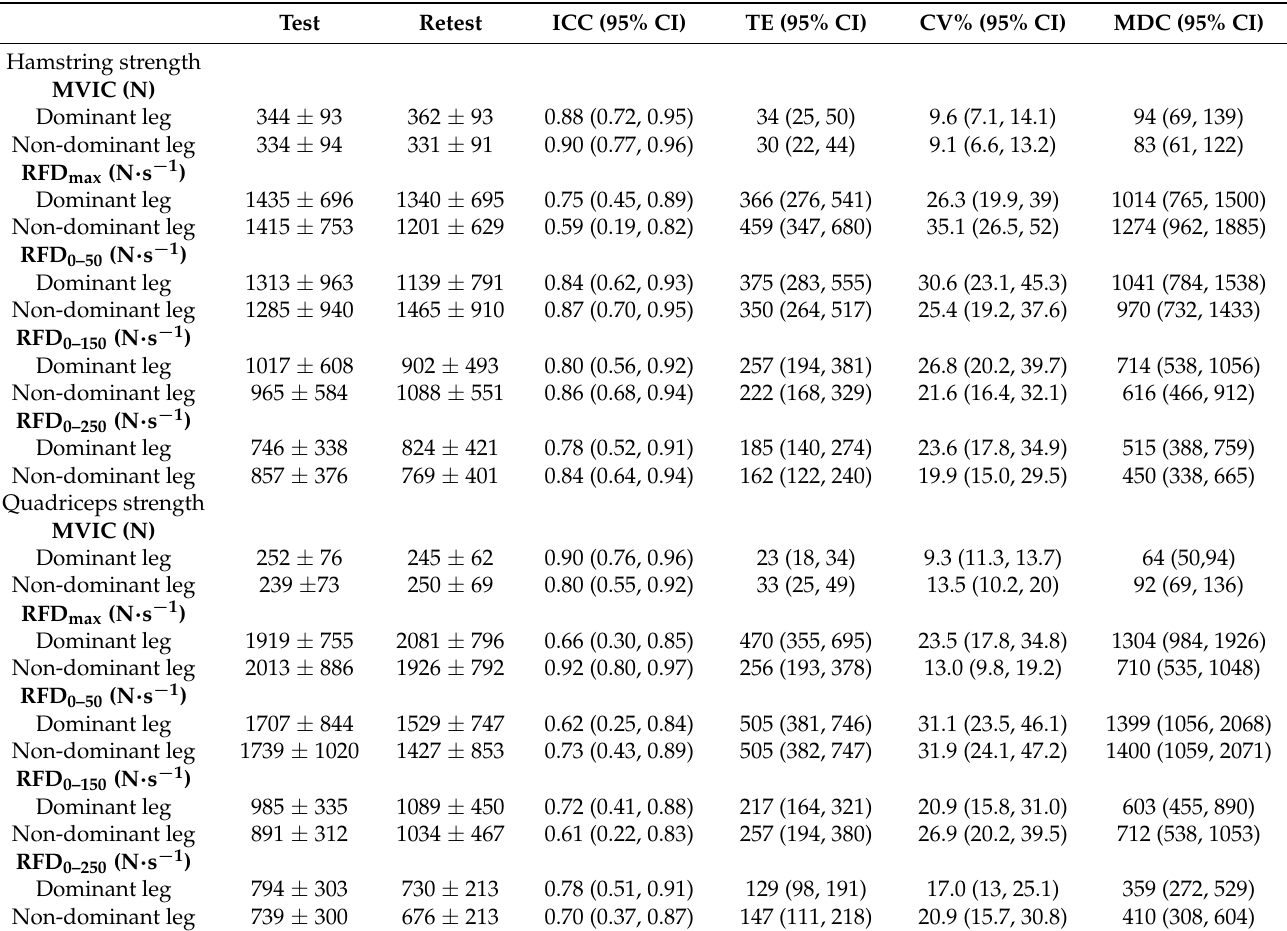
Table 1. Reliability of isometric hamstring and quadriceps strength measured through a field-based test in football